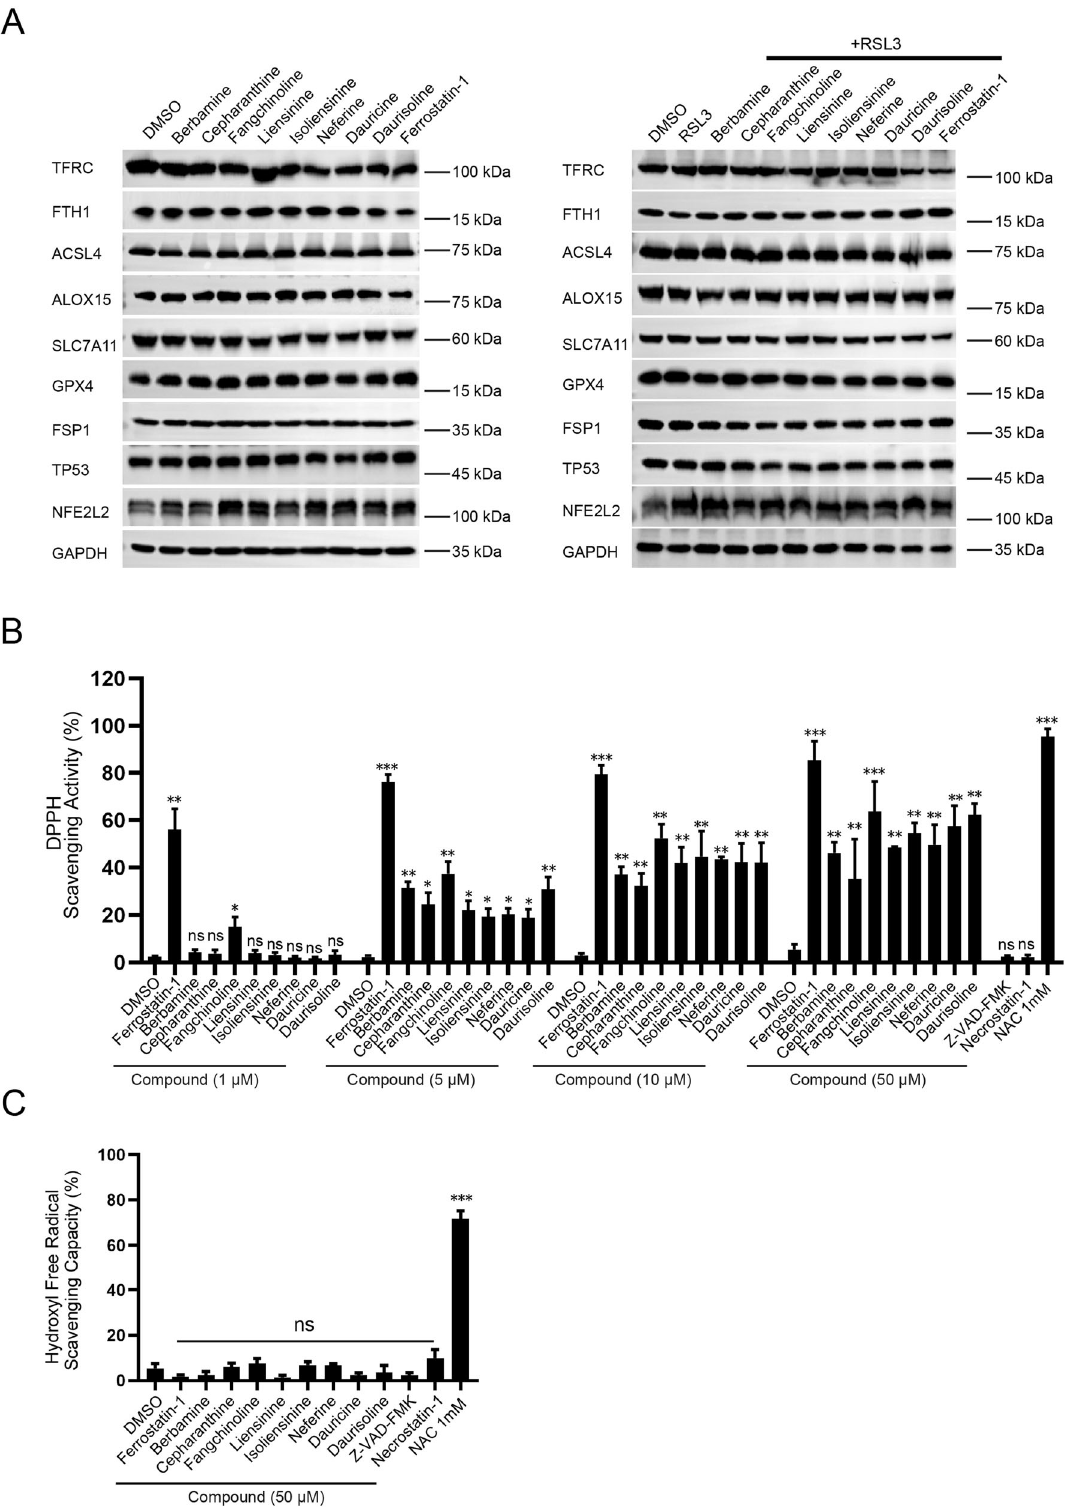
Fig. 5 ROS scavenging activities for BBIQs in cell-free assays. A Representative western blots for key ferroptosis regulators. BBIQ compounds do not affect the homeostasis of all proteins examined in either unstimulated or RSL3-stimulated HT1080 cells. Assays were repeated twice with similar results. B Cell-free DPPH free radical scavenging assay. BBIQs were tested at 1, 5, 10, and 50 μ M. Z-VAD-FMK and necrostatin-1 were tested at 50 μ M and NAC at 5 mM. Data represent mean ± s.d. from three independent repeats and p value (vs. DMSO) is determined by ordinary one-way ANOVA with Dunnett ’ s multiple comparisons test. ns, no signi fi cance; **, p < 0.01; ***, p < 0.001. C Cell-free hydroxyl radical scavenging capacity assay. The concentration for NAC is 5 mM. Data represent mean ± s.d. from three independent repeats and p value (vs. DMSO) is determined by ordinary one-way ANOVA with Dunnett ’ s multiple comparisons test. ns, no signi fi cance; ***, p < 0.001.